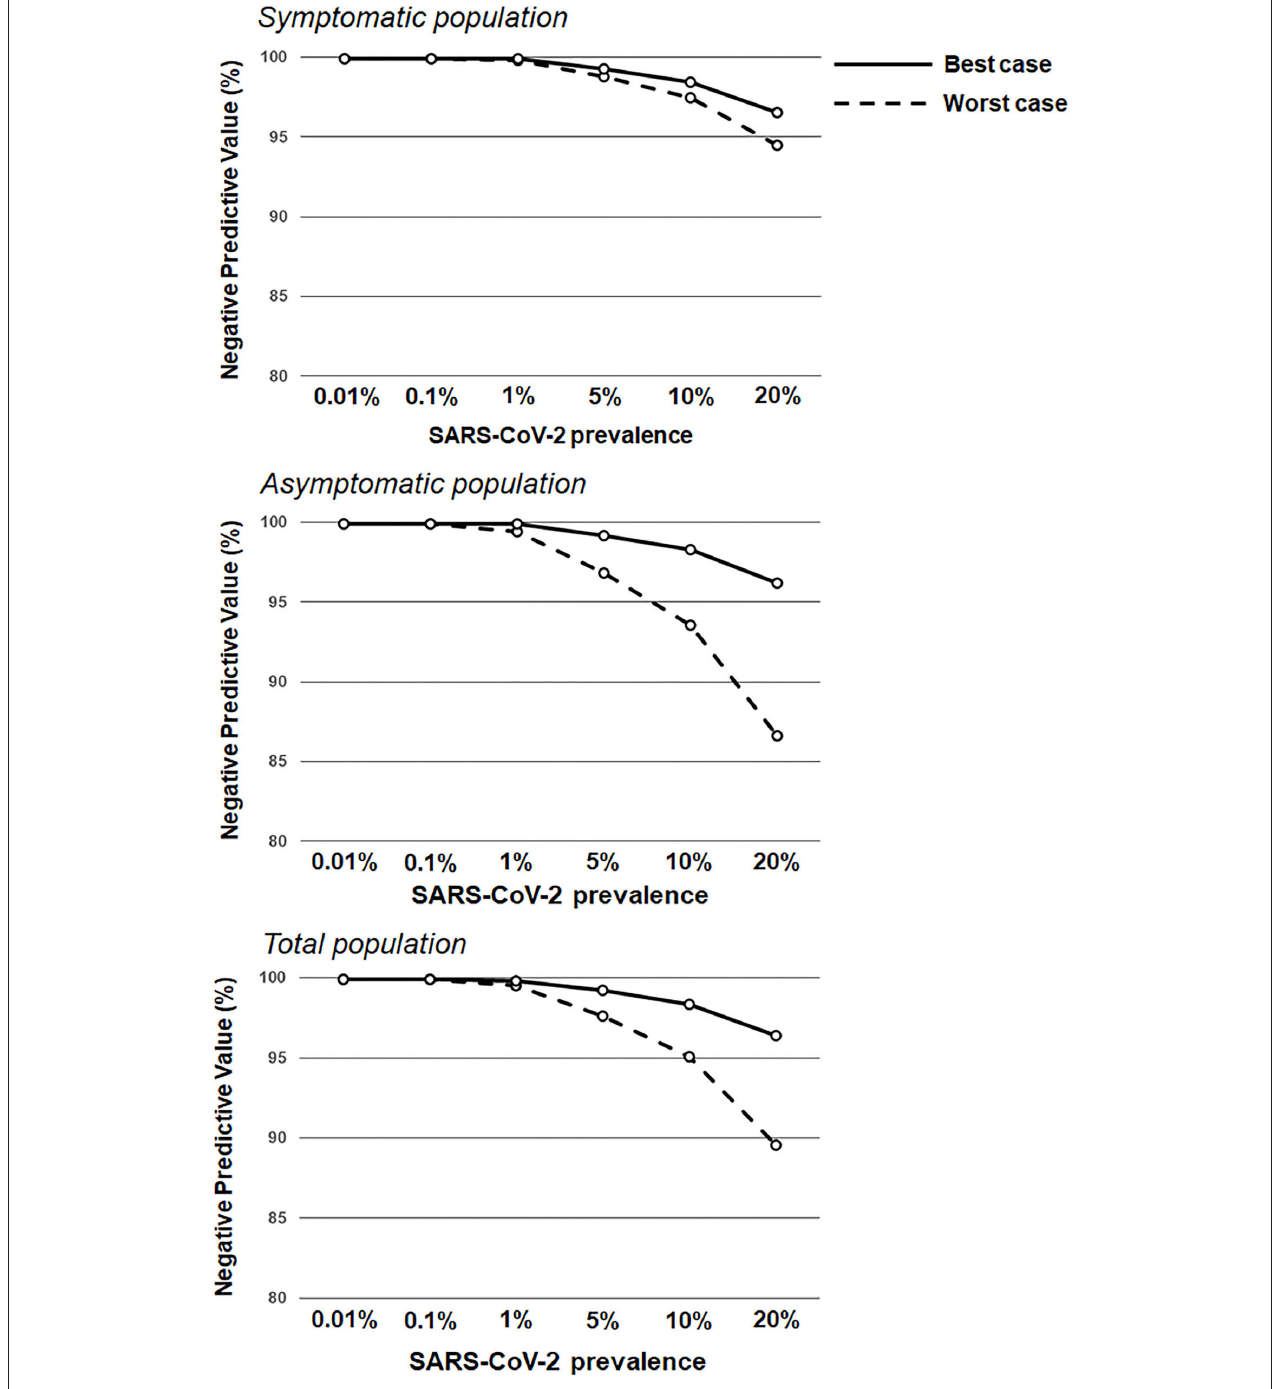
FIGURE 2 | Negative predictive values based on RAT sensitivity/specificity over a range of theoretical SARS-CoV-2 prevalence values. RAT negative predictive value estimates in the symptomatic population ( top ; sensitivity of 77.2 and 85.6% in the worst antigen diagnostic performance estimates and best antigen diagnostic performance estimates, respectively; and specificity of 97.9 and 99.9% in the worst antigen diagnostic performance estimates and best antigen diagnostic performance estimates, respectively) and the asymptomatic population ( middle ; sensitivity of 38.5 and 84.2% in the worst antigen diagnostic performance estimates and best antigen diagnostic performance estimates, respectively; and specificity of 99.4 and 99.9% in the worst antigen diagnostic performance estimates and best antigen diagnostic performance estimates, respectively), and the total population ( bottom ; sensitivity of 53.8 and 85.1% in the worst antigen diagnostic performance estimates and best antigen diagnostic performance estimates, respectively; and specificity of 99.1 and 99.9% in the worst antigen diagnostic performance estimates and best antigen diagnostic performance estimates, respectively) based on increasing prevalence values (0.01–20.0%).